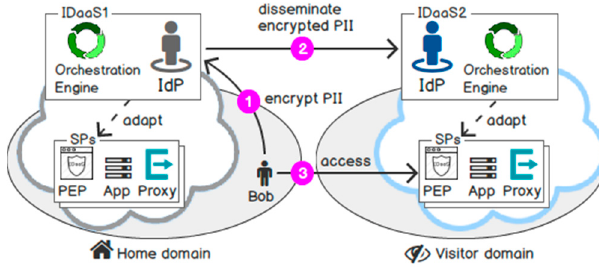
Figure 2. Identity-as-a-Service proposed